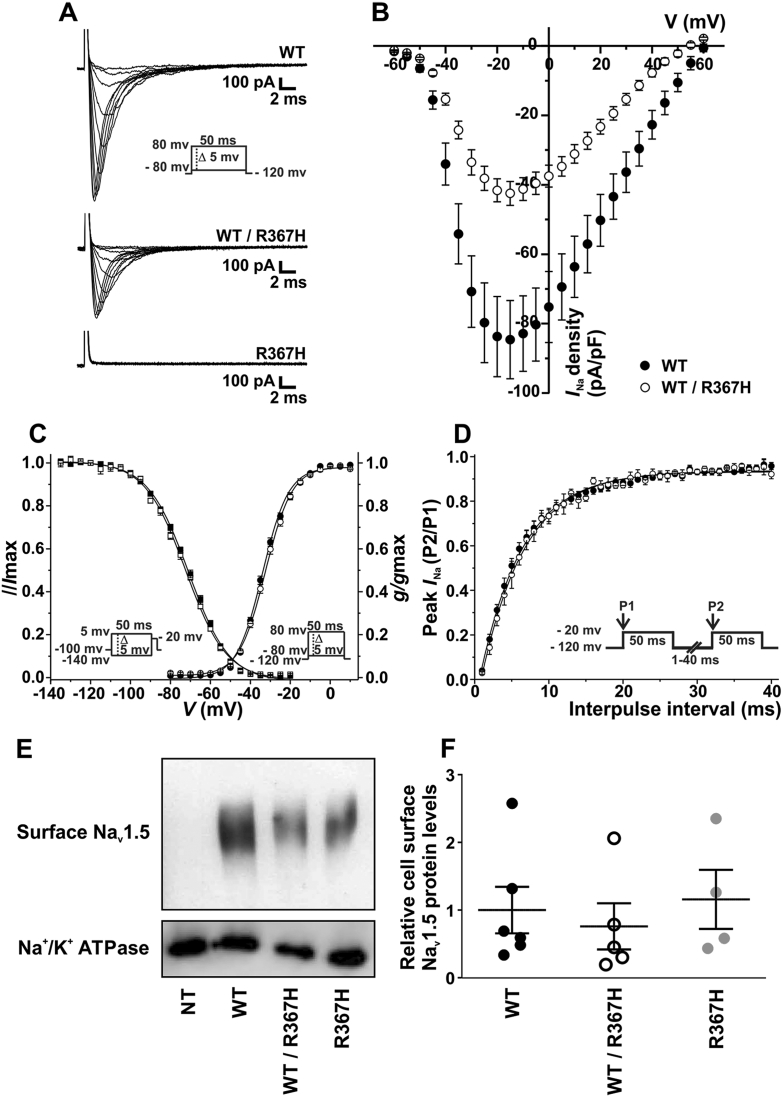
Nav1.5_R367H markedly decreases peak INa. (A) Representative whole cell sodium current traces recorded from WT, WT/R367H and R367H cells. Currents were elicited by depolarizing potentials as shown in the inset. Traces for pulses from − 60 mV to − 5 mV are shown. (B–D) Filled symbols are used to depict data for WT cells, and open symbols represent values for WT/R367H cells. Values are expressed as mean ± SEM. (B) Current-voltage (I–V) relationship. INa amplitude was normalized to the cell capacitance to obtain current density (INa density) values. Experimental points represent the peak-amplitude of INa density at each given voltage. (C) INa voltage-dependence of activation and steady-state inactivation for WT and WT/R367H cells. Conductance values for the activation curve were obtained from the peak current values taken from the I–V relationship. Symbols represent experimental data plotted against the given depolarizing voltage values. Steady-state inactivation protocol is shown in the inset on the left. Symbols represent experimental data plotted against preconditioning pulse values. Solid lines represent the Boltzmann fit of the experimental points. (D) Recovery from inactivation properties were studied by applying the double pulse protocol shown in the inset. A 50 ms depolarizing pulse to − 20 mV (P1) was followed by a hyperpolarizing pulse to − 120 mV of increasing duration (1–40 ms), that preceded a test pulse to − 20 mV (P2). The P2/P1 ratio values plotted against the recovery interval times were fitted to mono-exponential functions (solid lines). (E) Representative image of western blot detection of Nav1.5 and Na+/K+ ATPase proteins performed after cell surface biotinylation of non-transfected cells (NT), cells transfected only with the vector encoding Nav1.5_WT (WT), with the vectors encoding Nav1.5_WT and Nav1.5_R367H (WT/R367H) and only with the vector encoding Nav1.5_R367H (R367H). (F) Scatter plot showing the relative surface Nav1.5 protein expression. Intensity values were calculated as described in Methods and normalized relative protein expression was plotted for each of the replicates (dots). Lines represent means ± SEM.